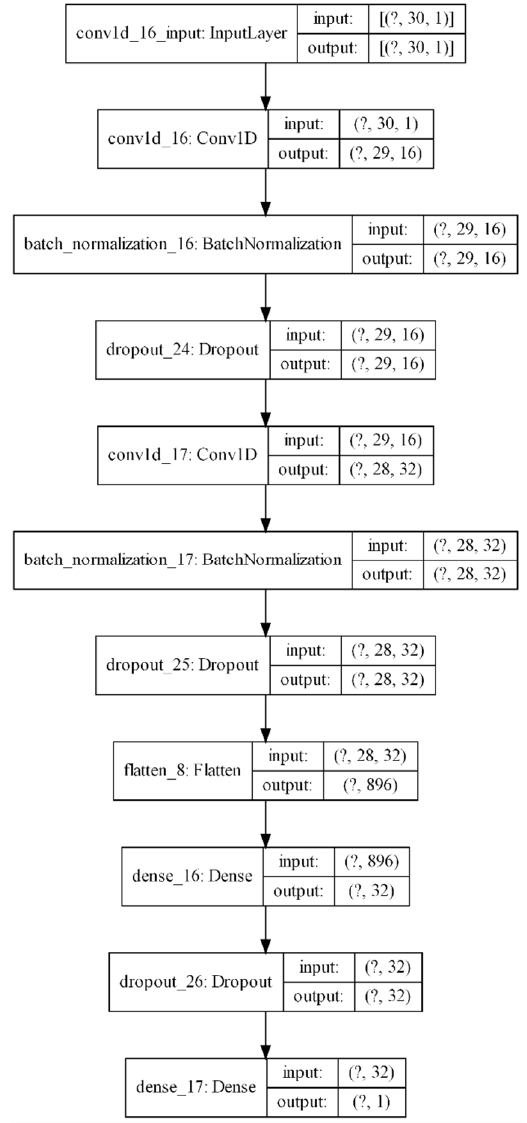
Figure 3. Architecture of the convolutional neural network model .